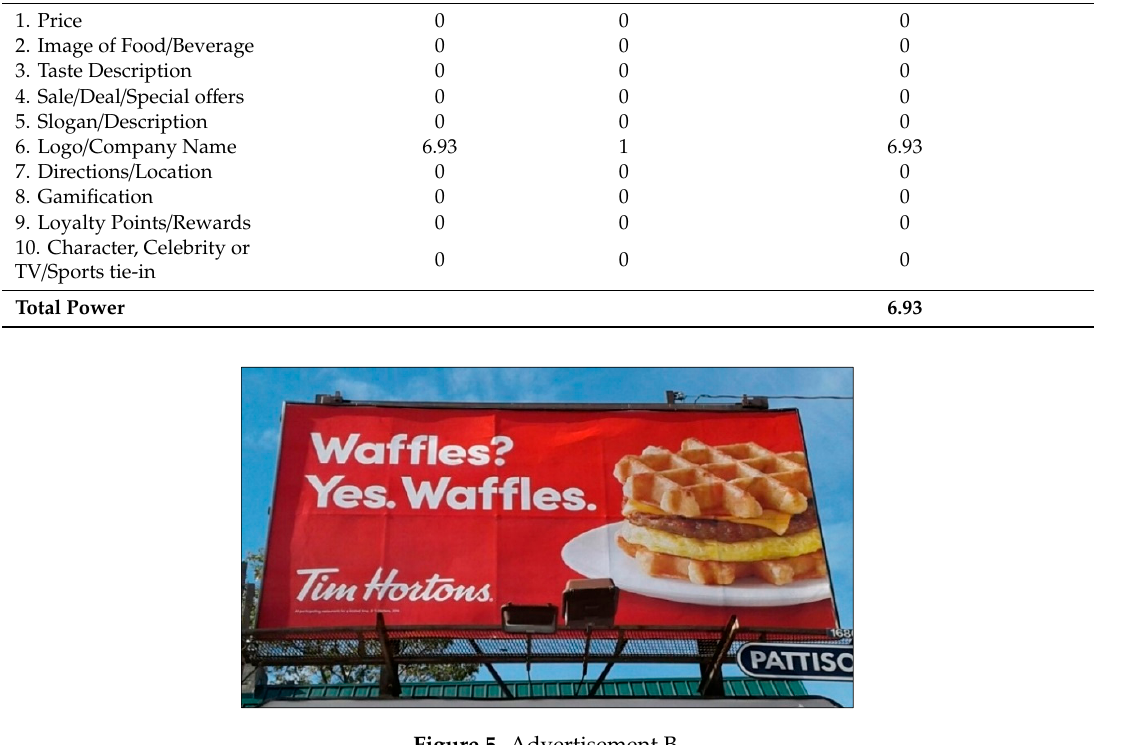
Table 6. Coding example using the teen-developed tool: Advertisement B.